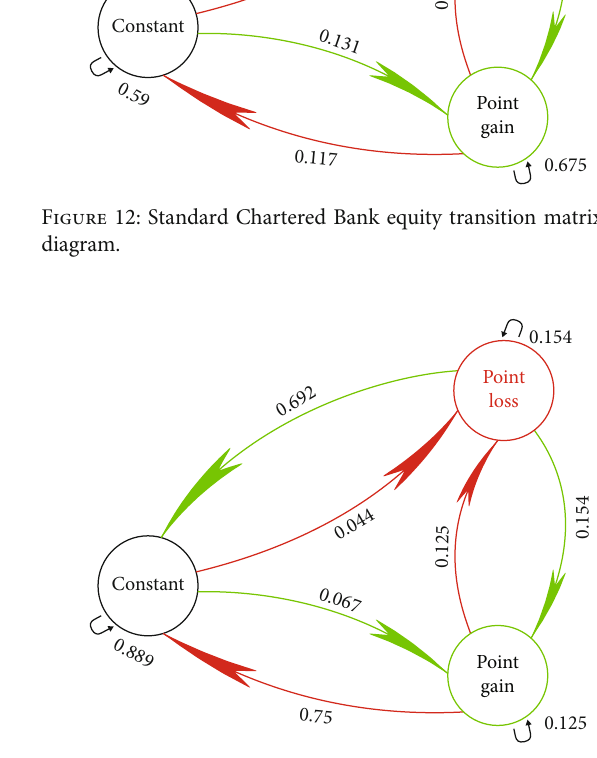
Figure 13: Trust Bank Gambia Ltd. equity transition matrix and diagram. Table 3: Chi-square test for goodness of fi t for the Markov chain